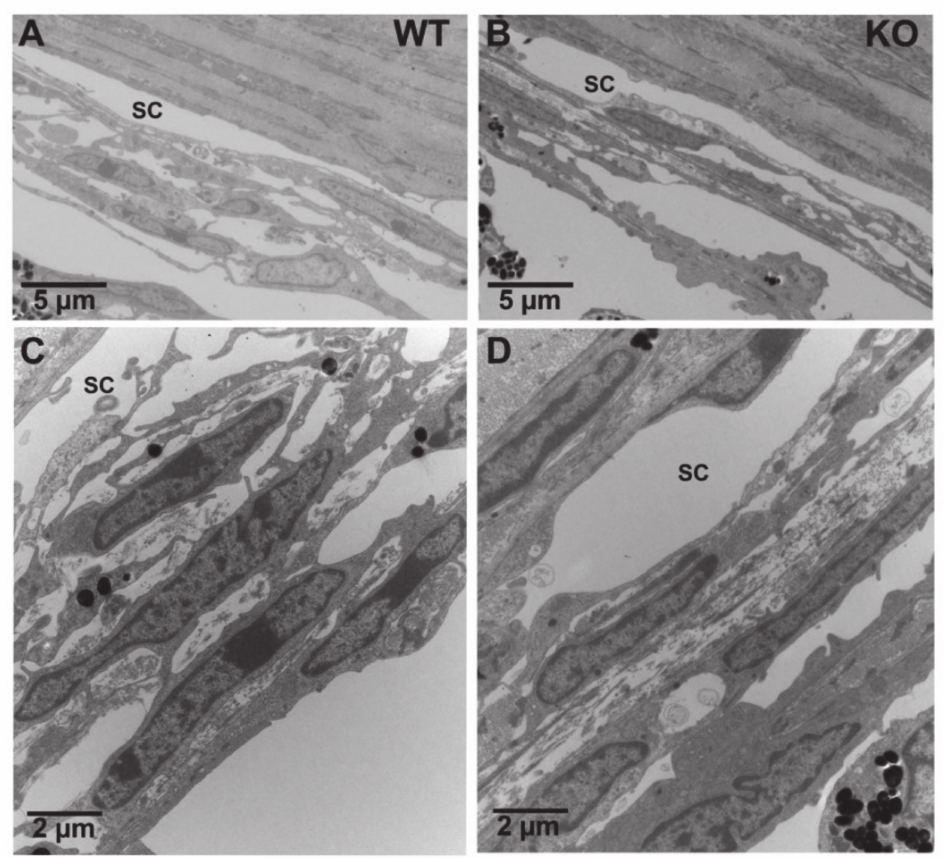
Figure 7. Morphological Comparison of Trabecular Meshwork between CTSB and CTSB ko mouse eyes. ( A – C ): Represen- tative electron microscopy images of the TM from CTSB mouse eyes at lower ( A ) and higher ( C ) magnifications. ( B – D ): Representative electron microscopy images of the TM from CTSB ko mouse eyes at lower ( B ) and higher ( D ) magnifications. Compared to CTSB mouse eyes, no obvious differences were observed in the endothelial cell of Schlemm’s canal (SC), cells and extracellular matrix in the juxtacanalicular connective tissue regions, and the endothelial cells and extracellular matrix core of trabecular beams in CTSB ko mouse